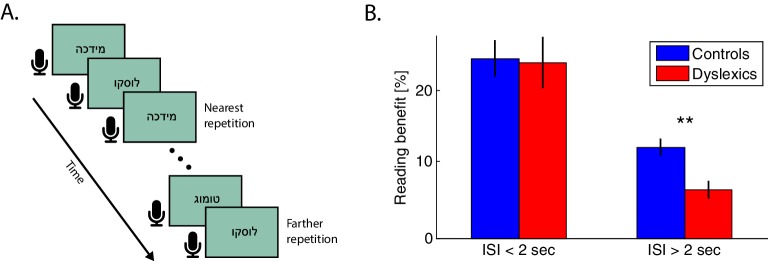
Dyslexics’ benefit from a previous exposure to the same non-word decayed faster than controls’.(A) Schematic illustration of the reading task. Subjects were asked to read the non-words aloud as quickly as possible. Presentation switched to the next word with the subject’s voice offset. The closest repetition of the same non-word was with one intervening non-word (i.e. an ITI of <2 s). (B) Benefit in RTs (response times from visual word presentation to vocal onset) as a function of the time interval between the first and second presentation of the same non-word. Improvement was calculated as the difference in RT between the first and second presentation of the same non-word in the block. At very short intervals (<2 s), the benefit was similar for both groups. However, this benefit decayed faster (at interval >2 s) among dyslexics (red) than among controls (blue; p<0.005). Error bars denote standard error (SEM).